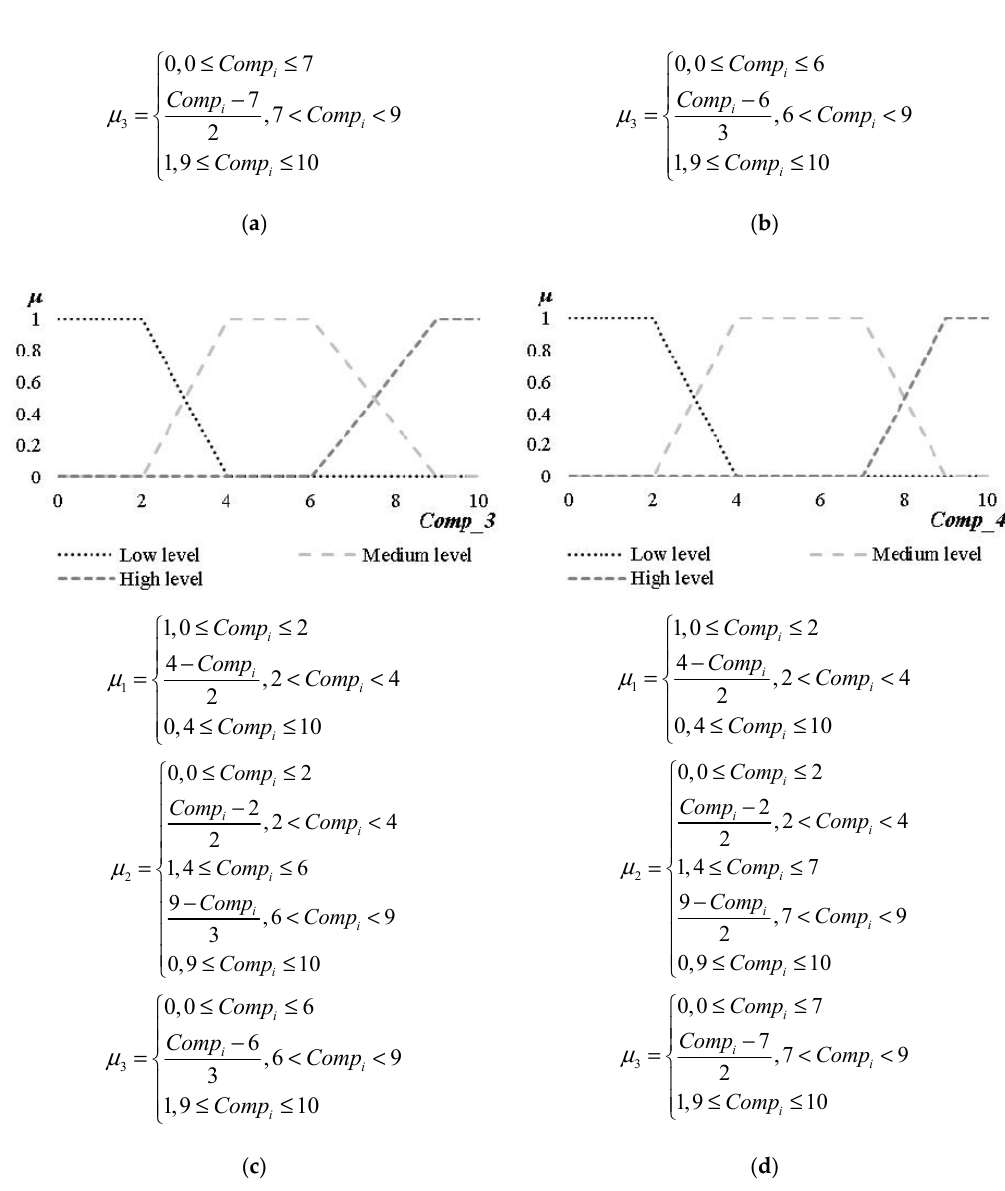
Figure 1. Membership functions regarding the levels of students’ professional